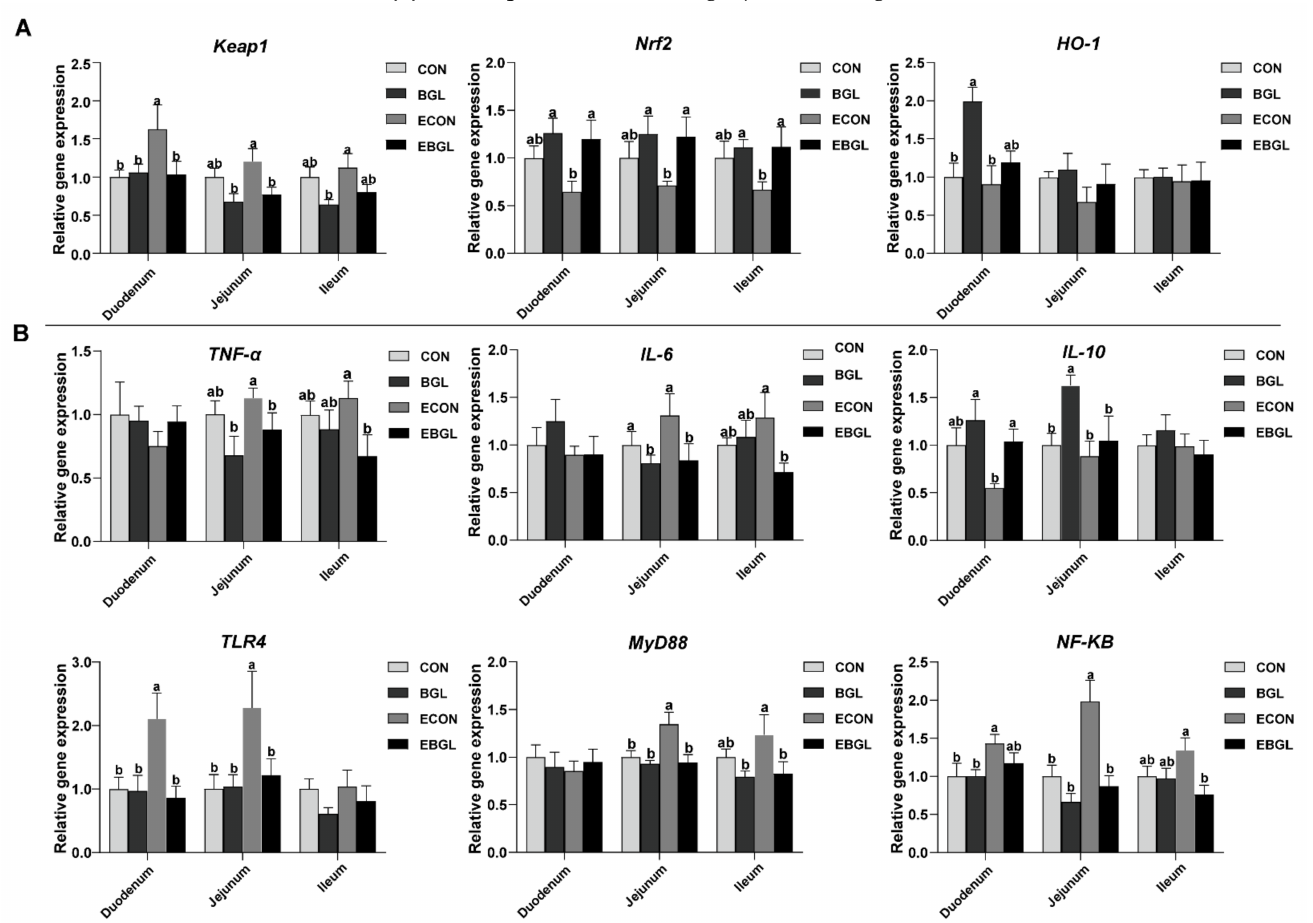
Figure 5. Effect of BGL on critical genes related to intestinal antioxidant capacity ( A ) and inflammation ( B ) in weaned pigs upon ETEC challenge. a, b, values within a row with different superscript letters are significantly different ( p < 0.05). CON, pigs were fed with a basal diet; BGL, pigs were fed with a BGL-containing diet (500 mg/kg); ECON, pigs were fed with a basal diet and challenged by ETEC; EBGL, pigs were fed with a BGL-containing diet and challenged by ETEC. TNF- α , tumor necrosis factor- α ; IL-6 , interlukin-6; IL-10 , interlukin-10; MyD88 , myeloid differentiation factor 88; NF- κ B , nuclear factor- κ B; TLR4, Toll like receptor 4; Nrf2 , nuclear factor erythroid 2-related factor 2; HO-1 , Heme oxygenase-1; Keap1 , Kelch-like ECH-associated protein